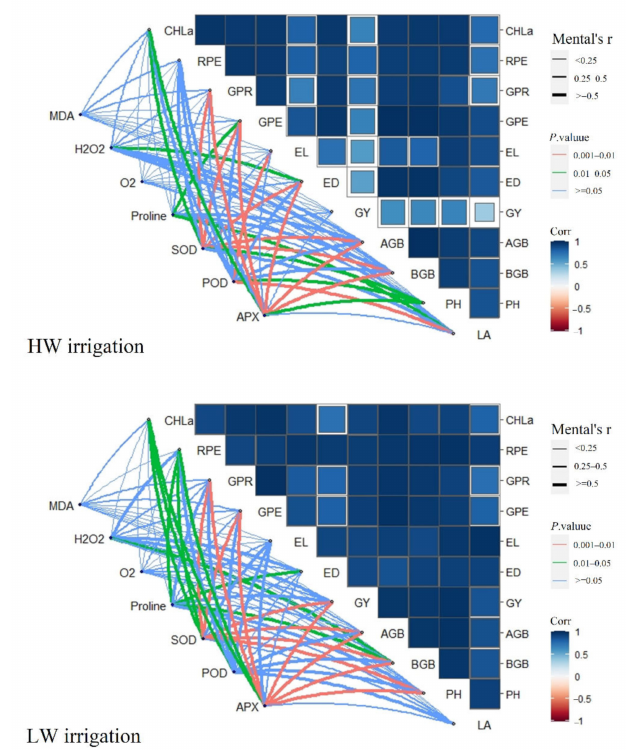
Figure 7. Correlation analysis of the yield, enzymes, chlorophyll, and ROS related parameters. CHLa, chlorophyll a; CHLb, chlorophyll b; GY, kernel yield; AGB, shoot dry matter, BGB; root dry matter; PH, plant height; LA, leaf area; MDA, malondialdehyde; H 2 O 2 , hydrogen peroxide; O 2 − , superoxide anion; SOD, superoxide dismutase; POD, peroxidase; and APX, ascorbate peroxidase.